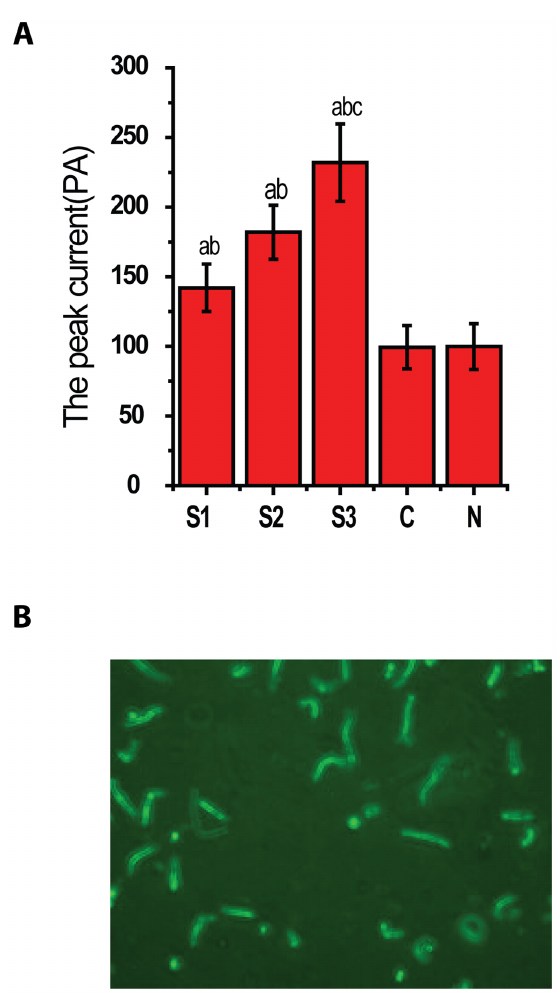
Figure 1. Characteristics of basilar artery smooth muscle cells. The graph A shows no significant difference for the membrane capacitance of BA smooth muscle cells in all group(P . 0.05, n=8/ group).The graph B showed a representative image of smooth muscle cells isolated from the BA.